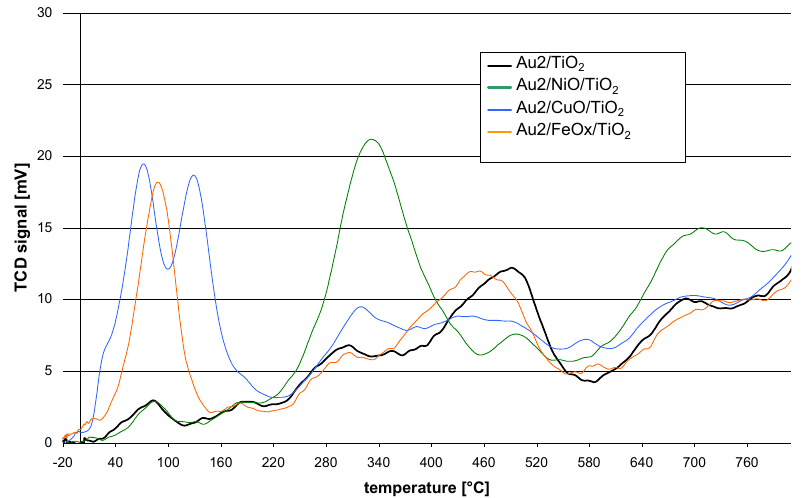
Figure 1. TPR curves of catalysts obtained by sequential deposition of base metal oxides followed by deposition of gold on TiO 2